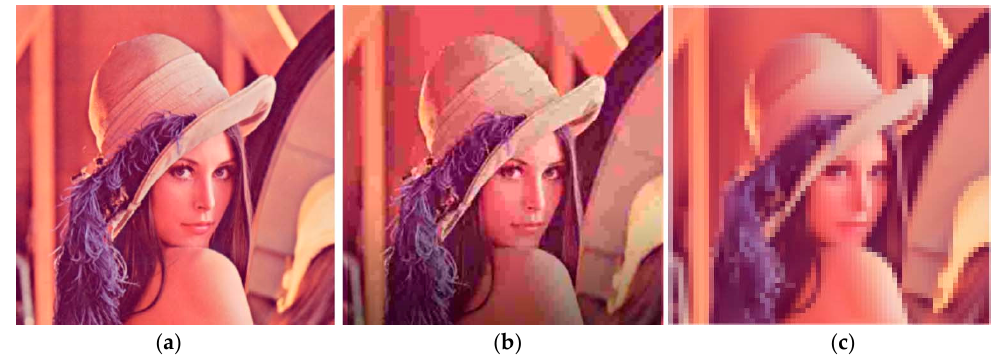
Figure 9. The image of Lenna and some application on it to compress data: ( a ) The original image; ( b ) Application of the noise filter; ( c ) Application of the compression